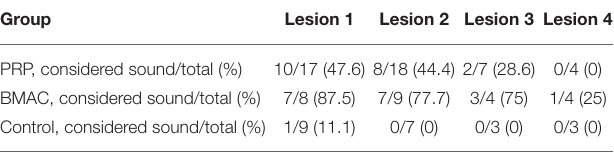
TABLE 4 | Ultrasound scores among the groups at the presentation days (T0). Group Lesion 1 Lesion 2 Lesion 3 Lesion 4 PRP, considered sound/total